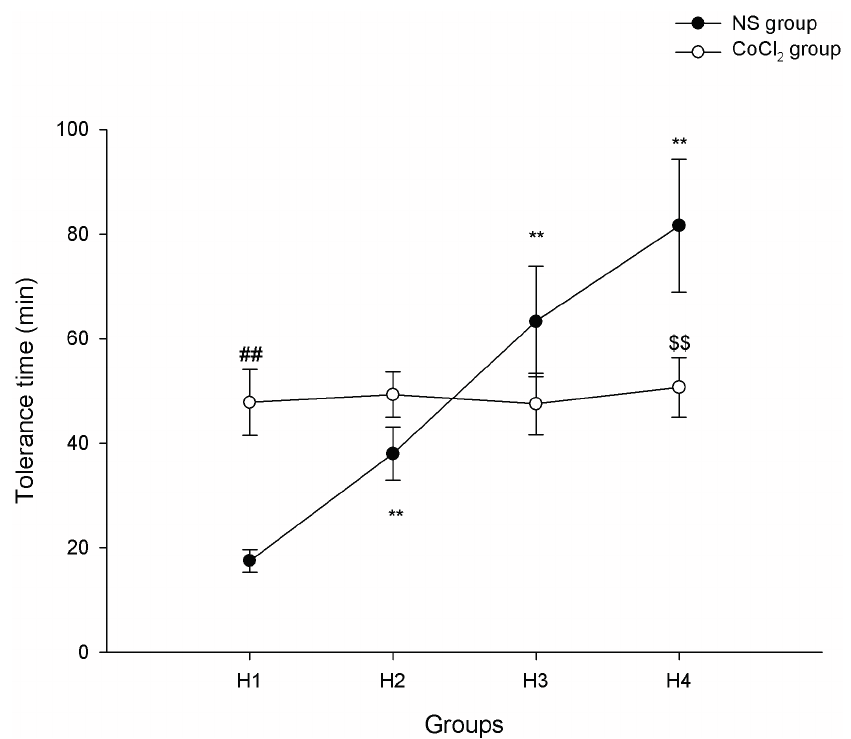
Figure 1. Tolerance time of mice exposed to hypoxia for 1–4 runs. ( n = 10; ** p < 0.01 as compared with the preceding runs in normal saline (NS) group; ## p < 0.01 H1 ; $$ p < 0.01 H4 vs. H4 H1 CoCl2 NS CoCl2